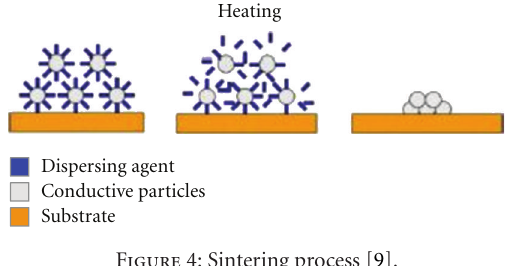
Figure 4: Sintering process